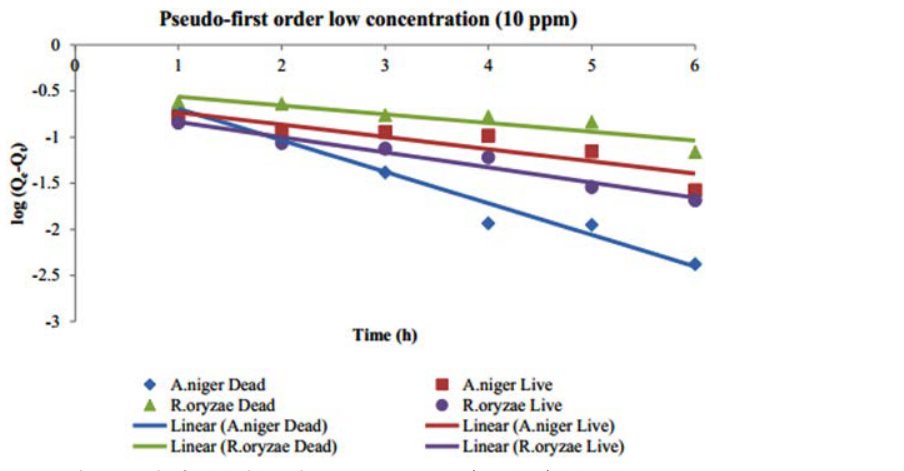
Fig. 11 . The Pseudo-first order at low concentration (10 ppm)